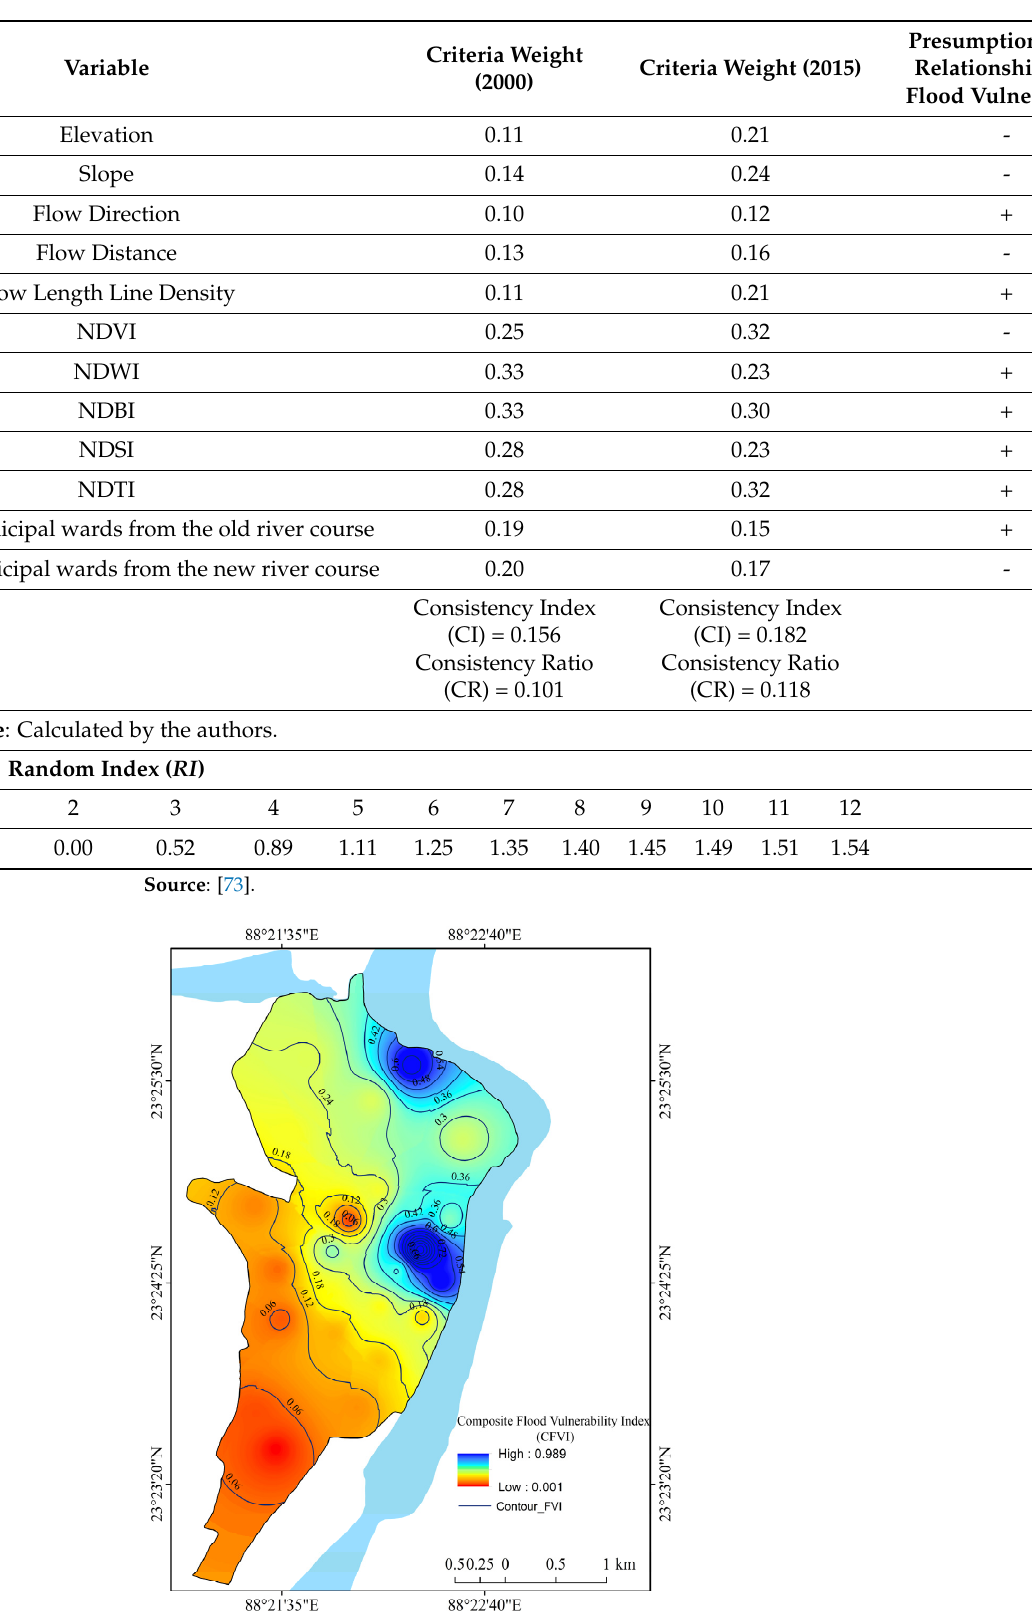
Table 13. Criteria weights of the MCDM process and proposed relationship of the indicators with flood vulnerability (2000 and 2015).